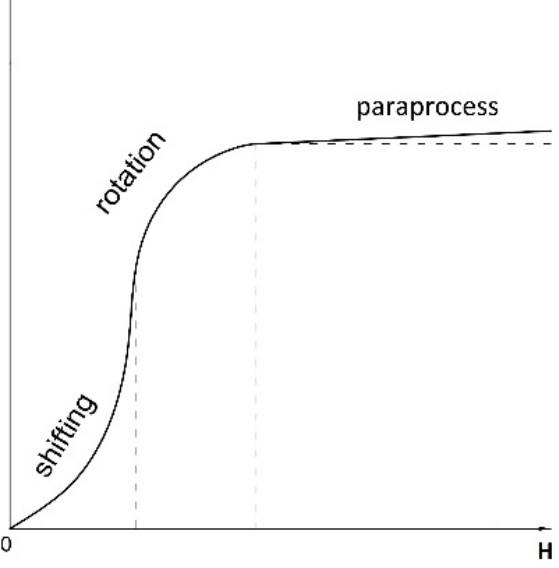
Figure 1. First magnetization curve of ferromagnetic magnetization. The described process refers to an idealized case and is a classic description that is appropriate for the response of a material to the excitation in the form of a change in the magnetic field intensity. However, the actual process is highly complicated because the movements of the walls and rotary movements may overlap, and the nature of the movements is strongly dependent on the structural features of the ferromagnetic material. In this scenario, the specific border points of the domain changes may be ambiguous. In addition, in the presence of other physical influences (see Equation (2)) on the object placed within even a weak magnetic field, the magnetization involving the rotary movement of the domains cannot be excluded, as indicated by the irreversible and nonlinear effects